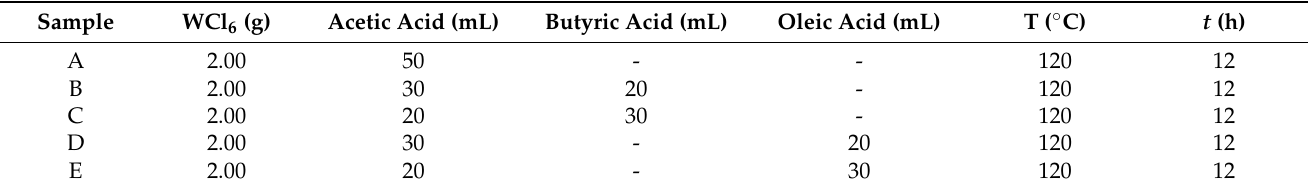
Table 1. Mass of WCl 6 , volume of carboxylic acids, growth temperature (T), and time ( t ).